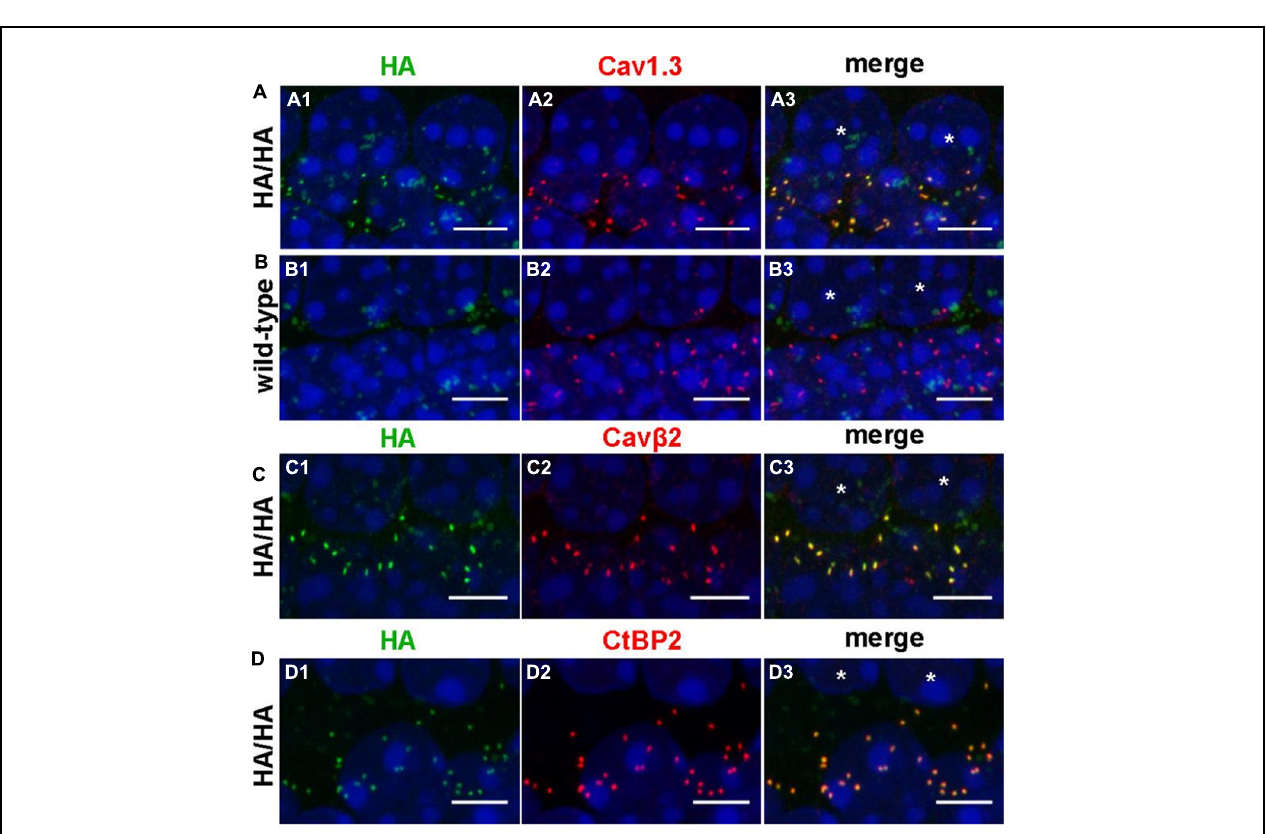
FIGURE 6 | Comparison of the protein localization of anti-HA-labeled Cav1.3 with immunolabeled Ca v 1.3, Ca v β 2 and CtBP2/RIBEYE in IHCs. (A–D) Whole-mount preparations of apical turns of the organ of Corti from adult Ca v 1.3DCRD HA / HA (A,C,D) and WT (B) mice were co-immunolabeled with anti-HA and anti-Ca v 1.3 ( A, B , 11 weeks), anti-HA and anti-Ca v β 2 ( C , P28), or anti-HA and anti-CtBP2/RIBEYE antibodies ( D , P37). Every image shows the basolateral poles of two adjacent IHCs the nuclei of which are indicated by asterisks in the rightmost column, respectively. HA staining (A1,C1,D1) largely